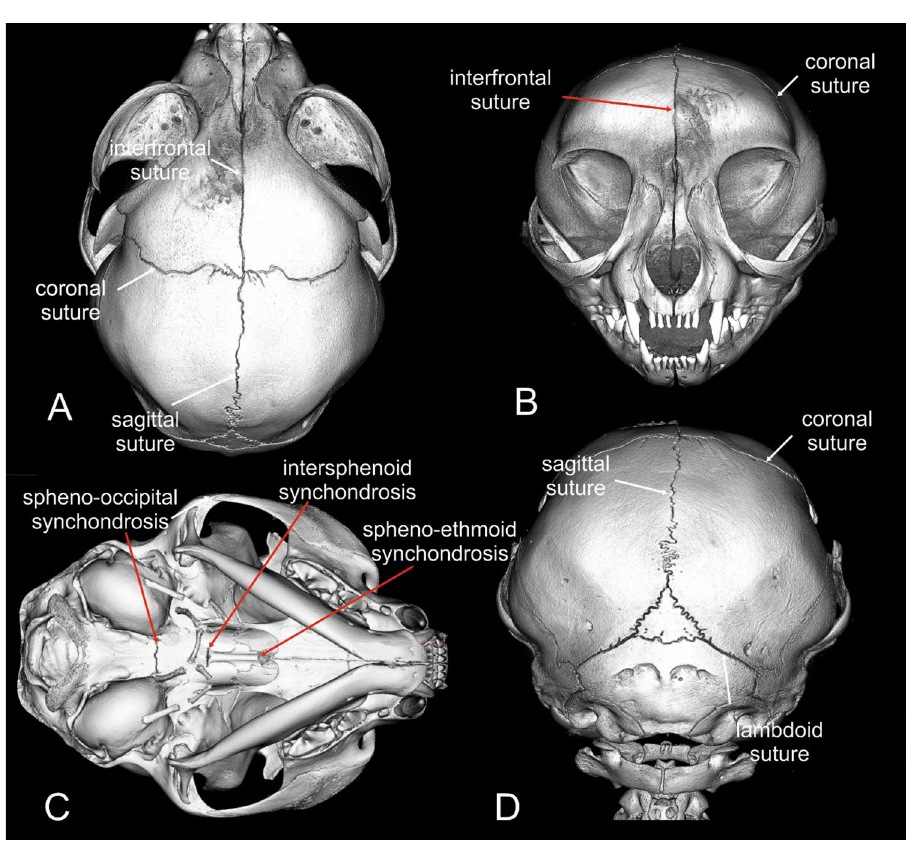
Figure 1. 3D head models based on micro-CT images of a 6-month-old Domestic Shorthair cat in a dorsal ( A ), frontal ( B ), ventral ( C ) and caudal view ( D ) displaying the examined sutures and